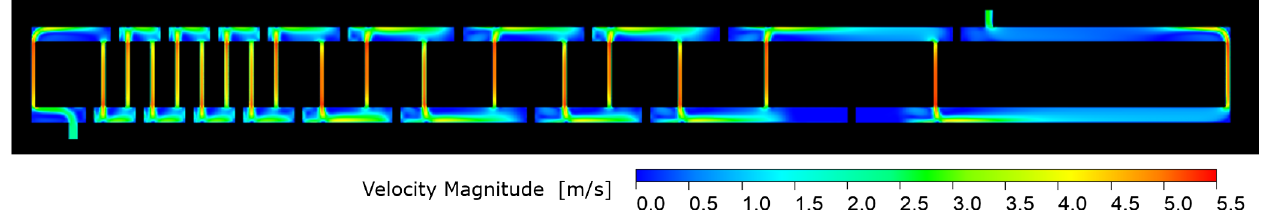
FIG. 10. 2D contour of velocity magnitude in the target prototype cooling system (serpentine configuration), obtained by means of CFD calculations. The water flow reaches high velocities of around 4 m = s in the 5 mm gap between the target blocks.